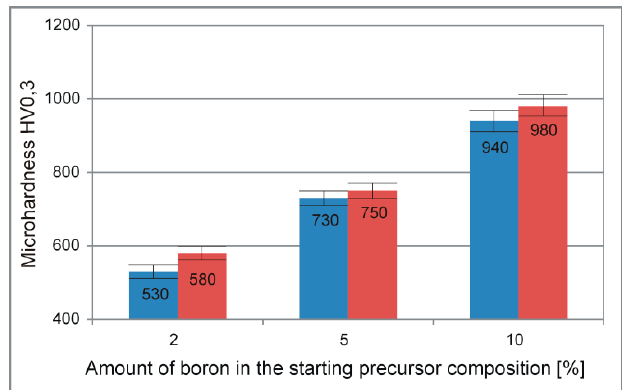
Figure 9. Microhardness analysis of the obtained composite sinters conducted for different PPS temperature regimes (blue—900 °C, red—1100 °C) and starting precursor compositions (2%, 5%, 10%).